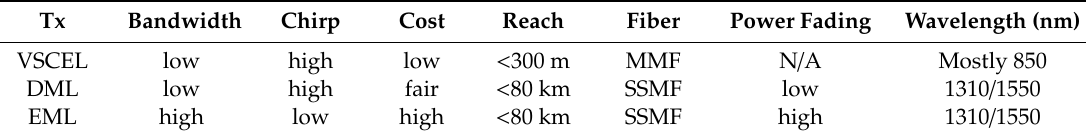
Figure 1. Typical configuration for short-reach PAM4 transmission system. Table 1. Comparison of different transmitters [54–59].